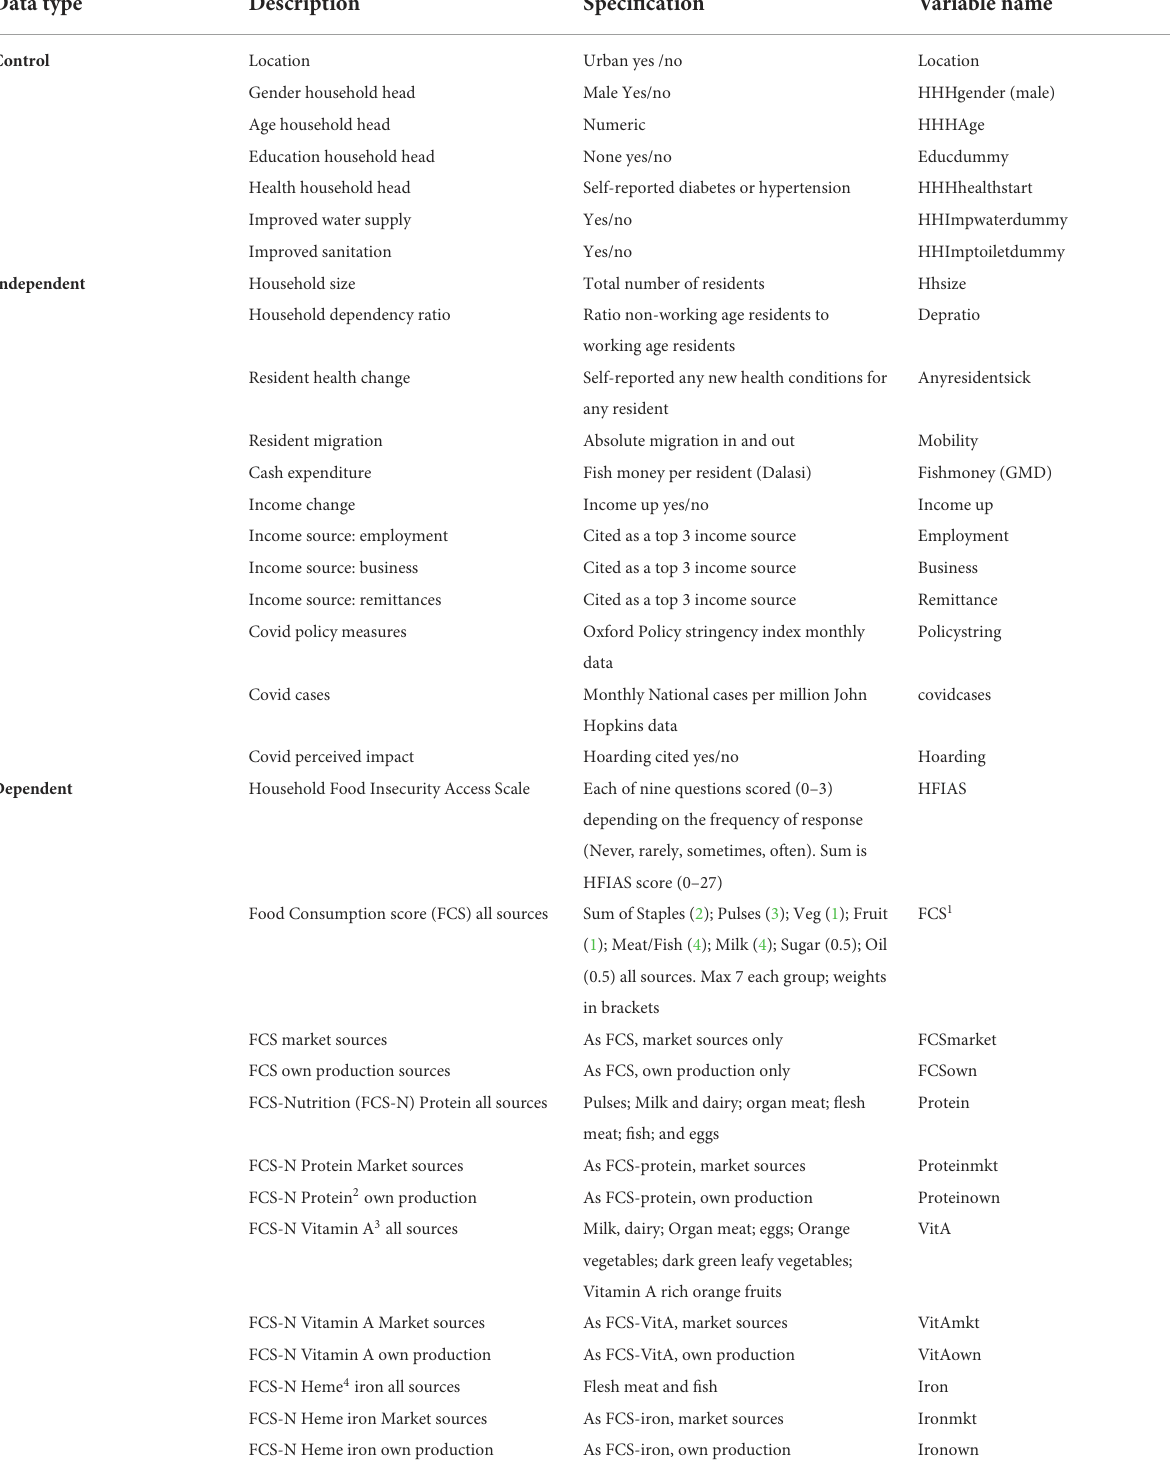
TABLE 3 Variable